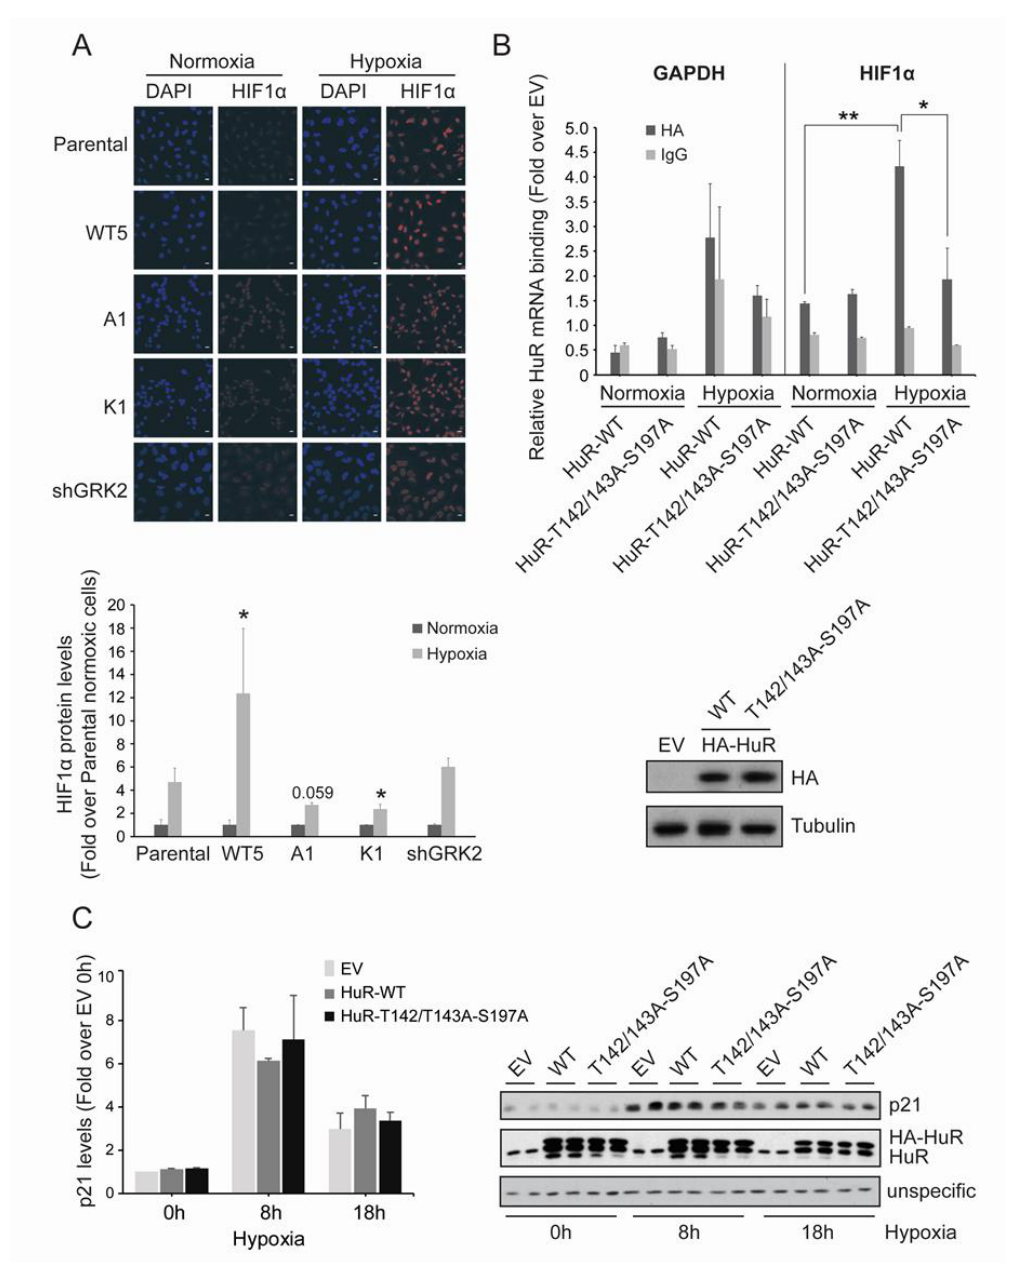
Figure 4. GRK2 kinase activity is required for HuR-induced upregulation of HIF1 α . ( A ) HeLa stable cell lines were cultured under hypoxia for 2 h and HIF1 α levels were analyzed by immunofluorescence. Values are mean ± SEM (fold-change over parental cells in normoxia) from 3–4 independent experiments. * p < 0.05 (Student’s t -test) comparing the changes in hypoxic HIF1α levels in Hela stable cells lines, with those observed in hypoxic parental cells. Representative images are shown. Scale Bar = 10 µ m. ( B ) HeLa cells were transiently transfected with pcDNA3 as empty vector (EV), HA-HuR WT, or HA-HuR-T142/143A-S197A, and cultured for 4 h under hypoxia. Total lysates were then immunoprecipitated with either an HA antibody or control IgGs. RNA was purified from